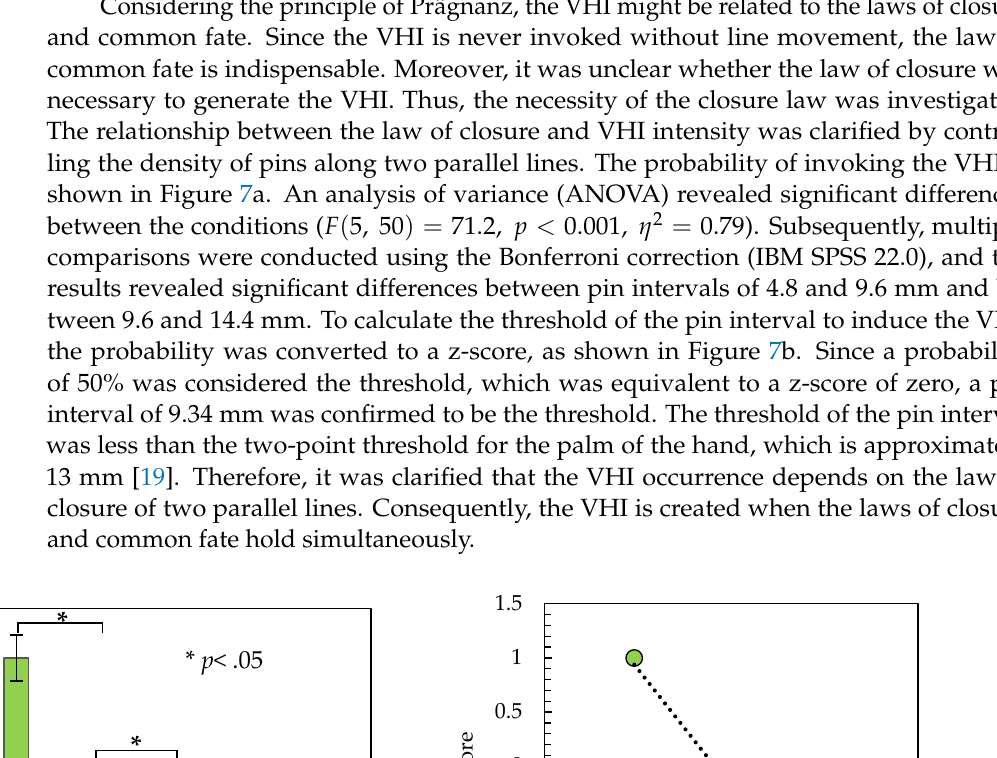
Figure 6. Six types of stimulus conditions. The distance between the pins that made up the lines were 2.4 and 55.2 mm under the highest and lowest density conditions, respectively.